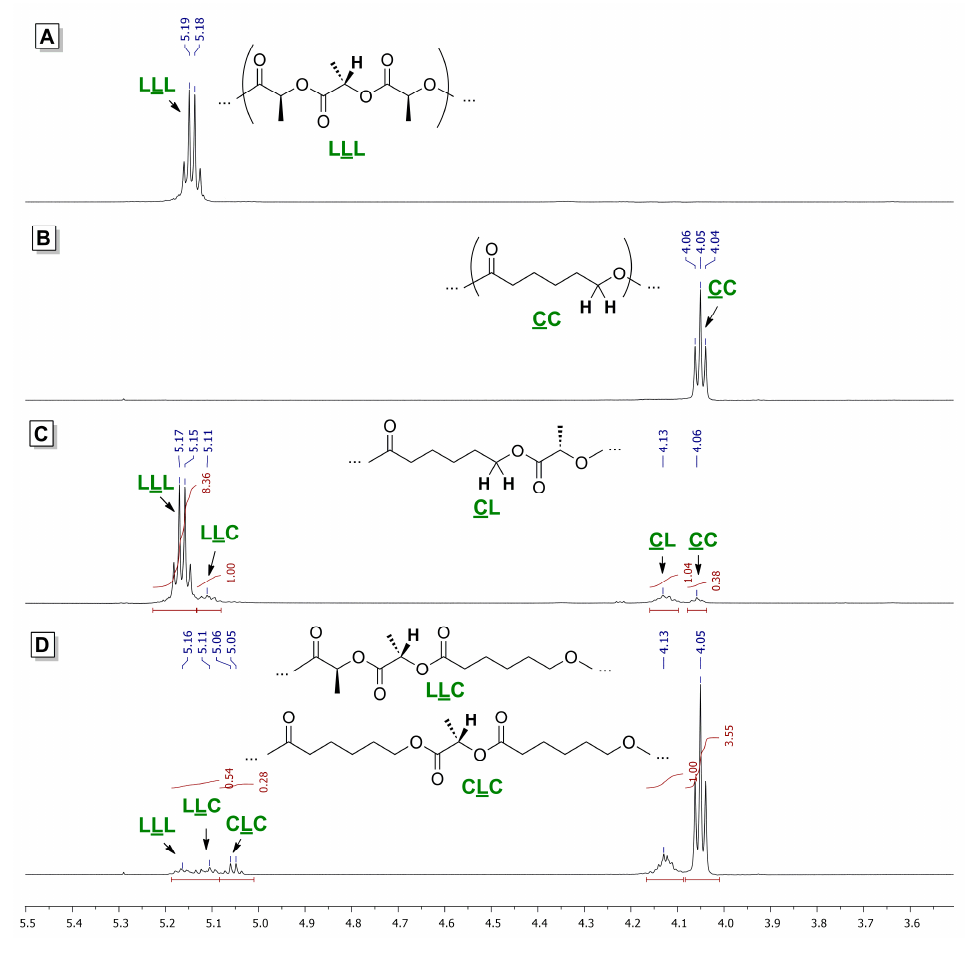
Figure 3. 1 H NMR spectra (CDCl 3 , 20 °C, 600 MHz) of PLLA ( A ), PCL ( B ) and L LA/ ε CL copolymers obtained at the 1:5 L LA/ ε CL ratio using complexes 1 ( C ) and 3 ( D ).